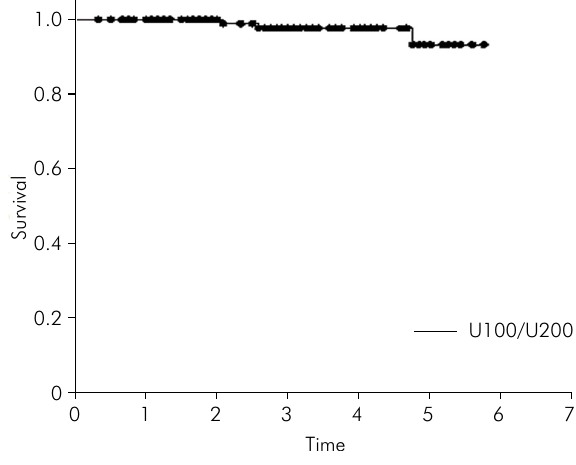
Figure 2. Kaplan Meier survival curve of metal-ceramic single